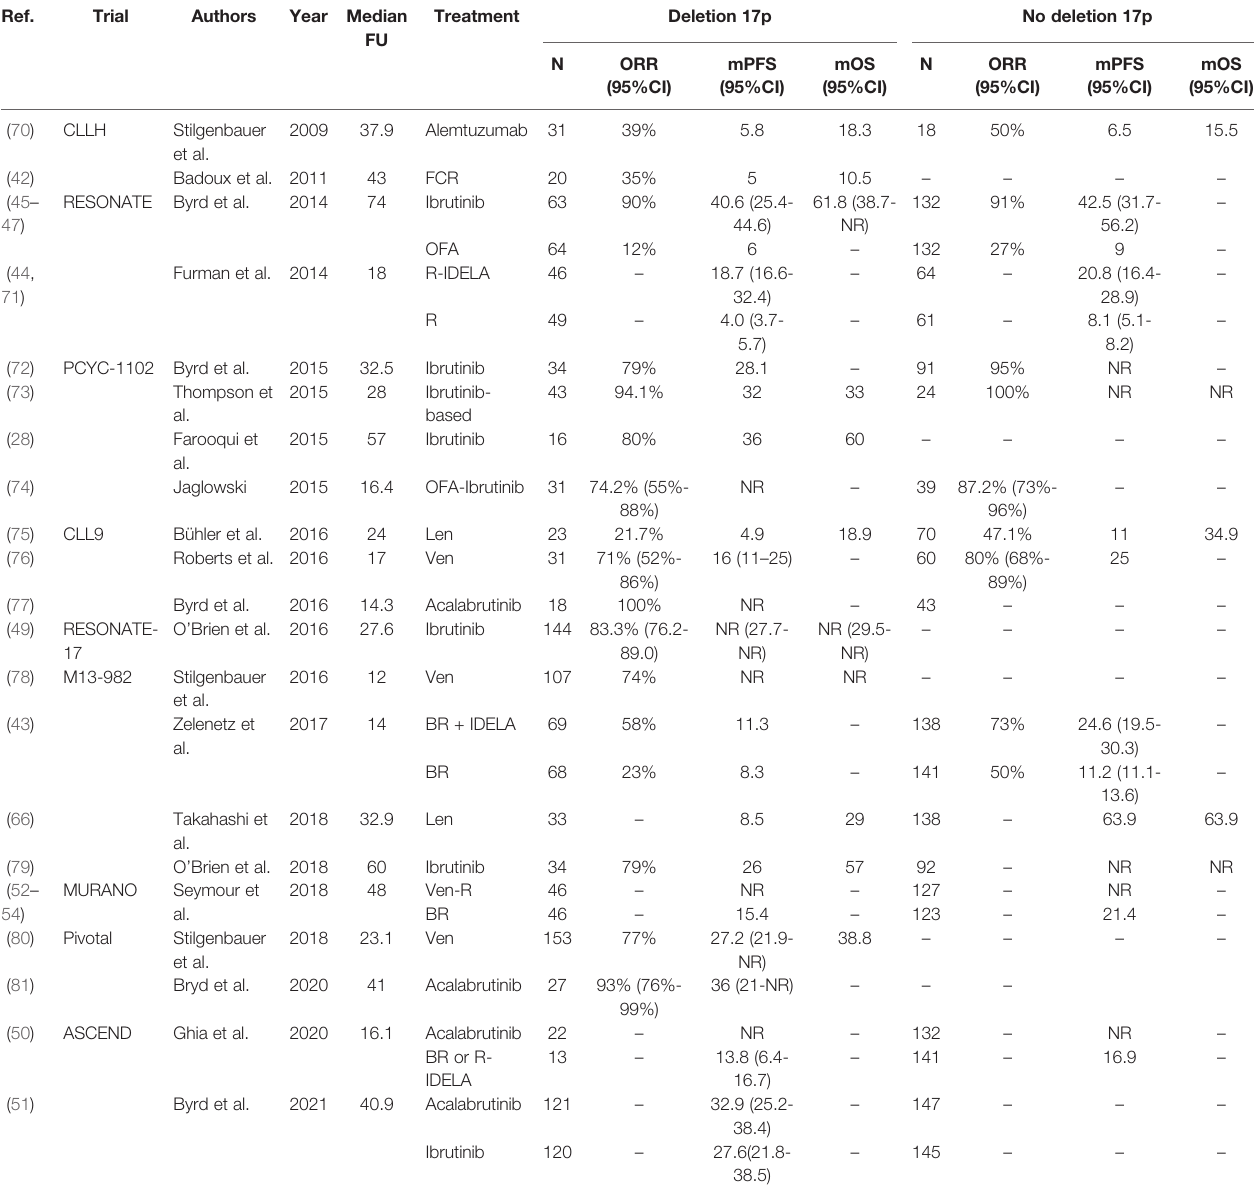
TABLE 2 | An overview of clinical trials comparing treatment regimens for relapsed or refractory CLL patients with TP53 aberrations.